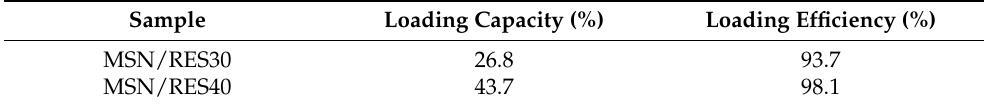
Table 1. Loading efficiency and loading capacity of samples loaded using the evaporation method.